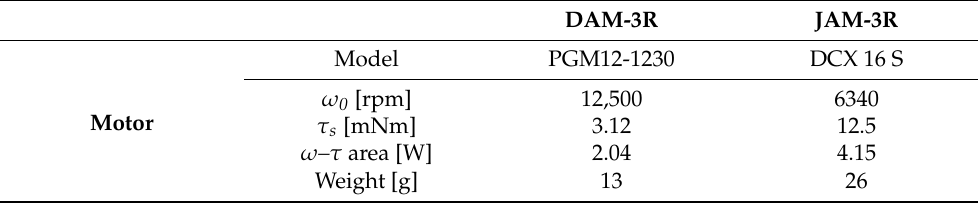
Figure 3. A three-link planar manipulator equipped with a conventional joint actuation mechanism under the effects of gravity. Table 1. Specifications of the commercial motors selected for the DAM-3R and JAM-3R .